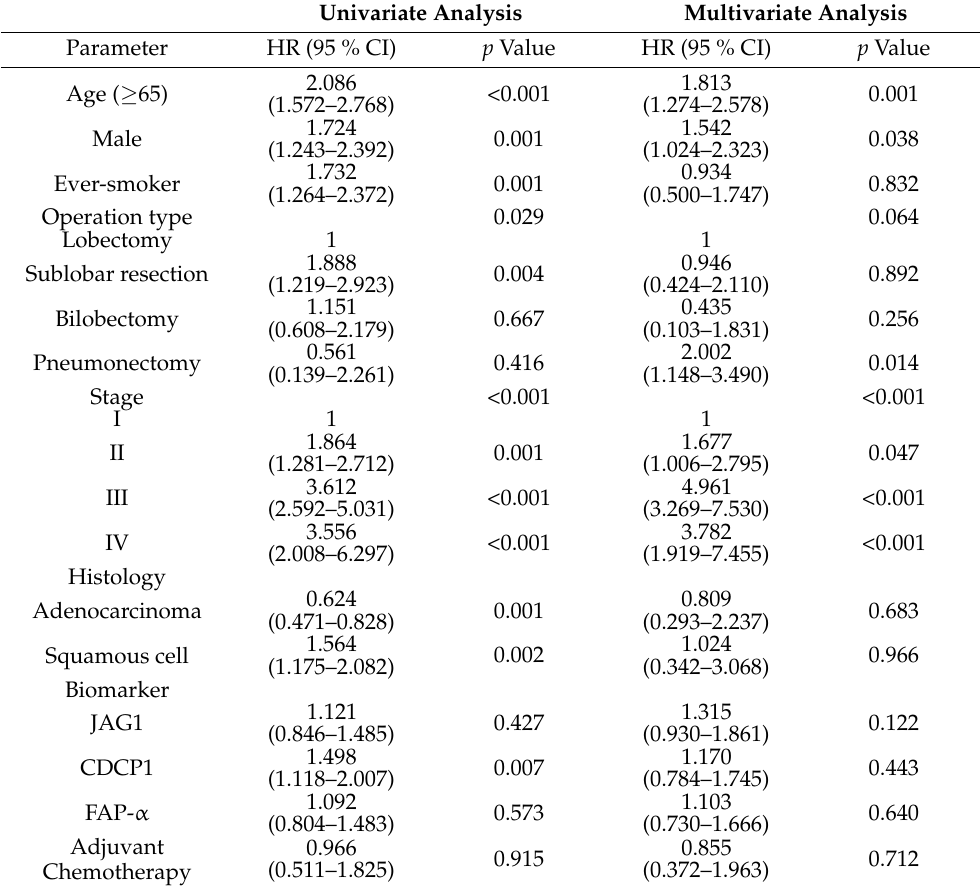
Table 3. Cox regression analysis for 5-year overall